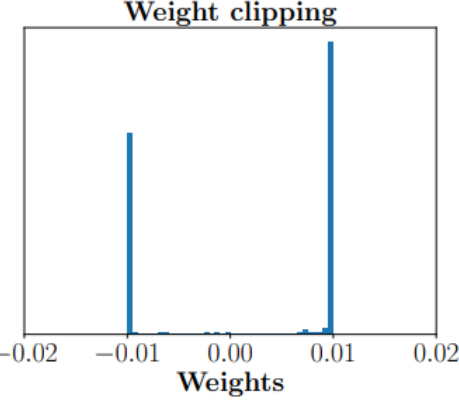
Figure 3. Weight clipping.